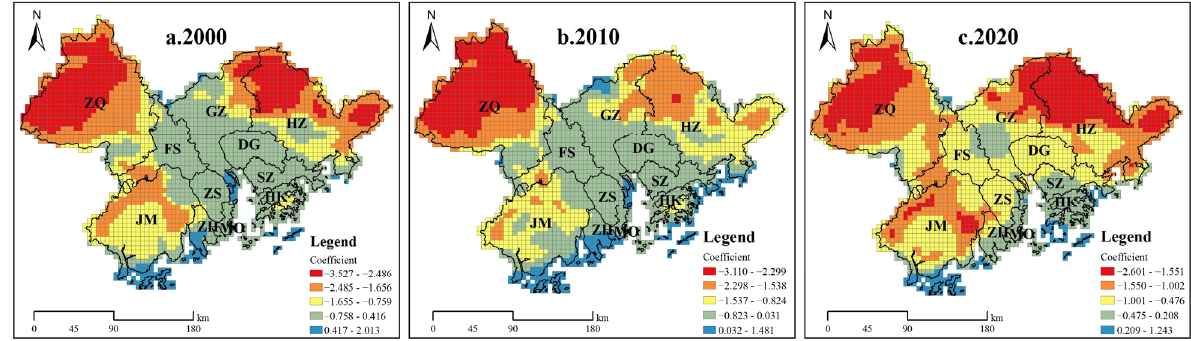
Figure 8. Spatial distribution of regression coefficients for the UL and EHI, 2000–2020.